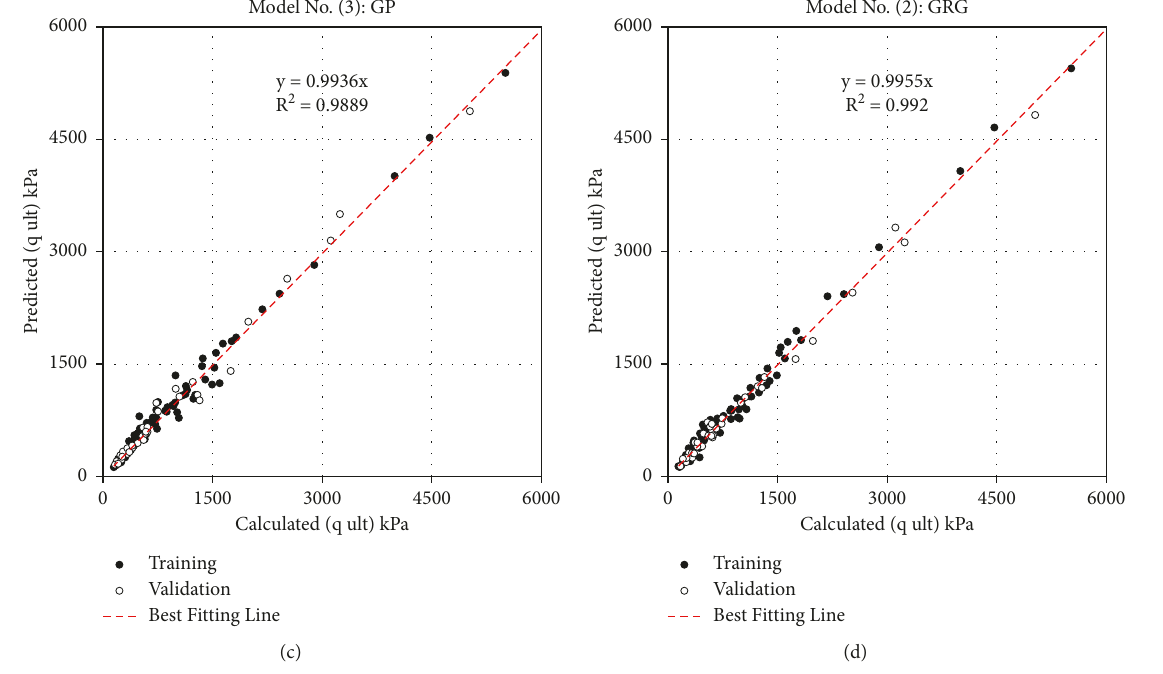
Figure 4: Relationship between predicted and calculated (UBC) values using the developed models.